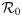
Sensitivity of R0 with varying each individual parameter; β = [0.3, 1.5], p = [0.1, 0.9], η = [0.1, 0.5], γ = [0.1, 0.5], f = [0.1, 0.5], α = [0.1, 0.5] (the baseline parameter values are given in Table 1).